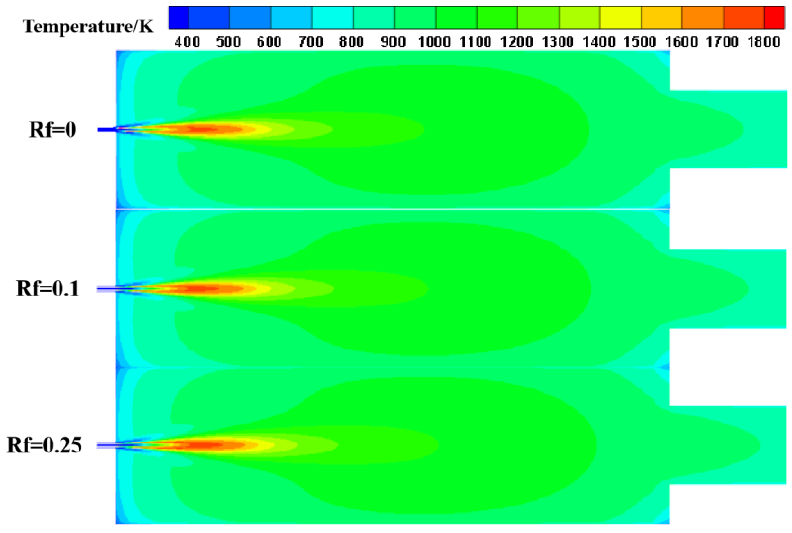
Figure 8. Combustion temperature nephogram of three hydrogen mixing ratio conditions.